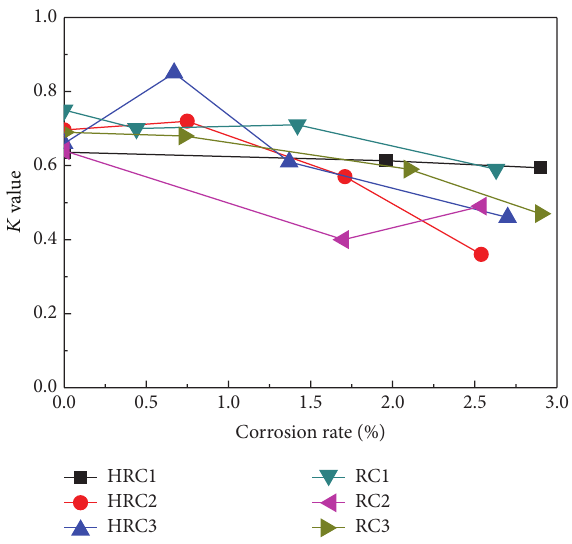
Figure 6: 𝐾 versus corrosion